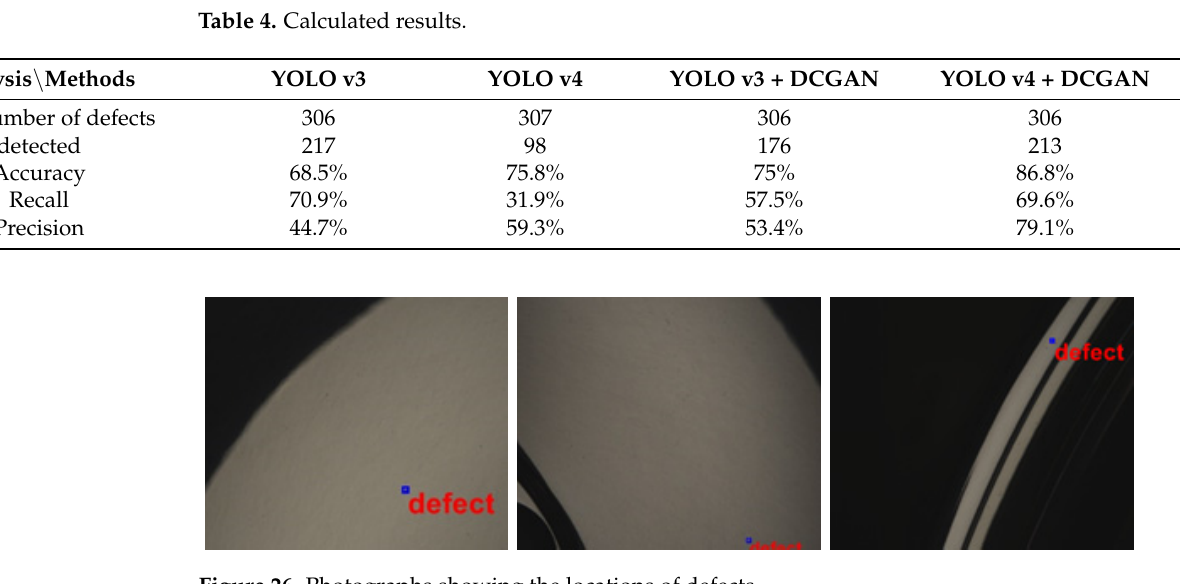
Table 4. Calculated results.